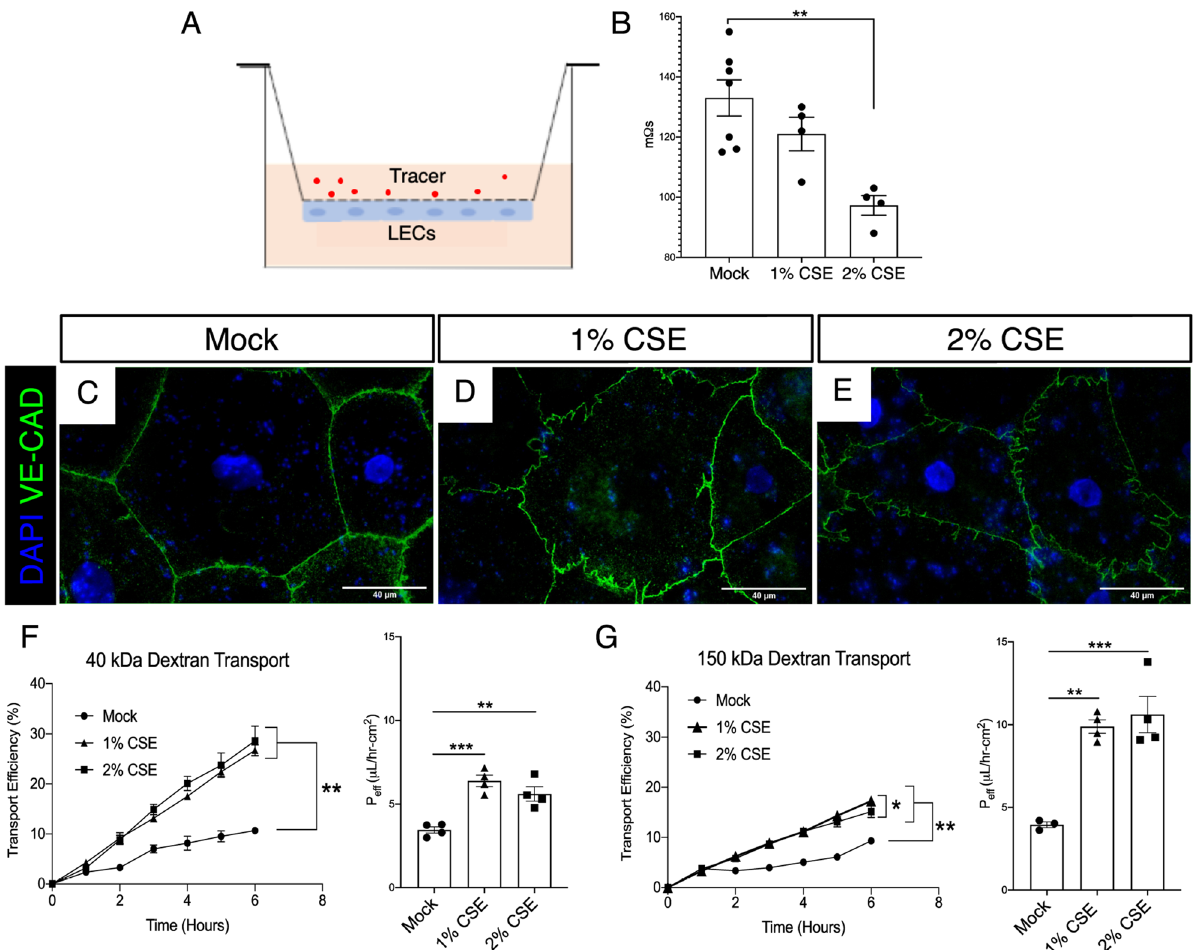
Figure 7. Cigarette smoke extract increases LEC permeability in vitro. ( A ) Schematic of LEC transport model where LECs are seeded on the bottom of a flask and transport of a fluorescent tracer across the monolayer is assessed. ( B ) Transendothelial electrical resistance (TEER) of a monolayer of LECs after treatment with 1% or 2% CSE for 12 h. ( C – E ) Representative fluorescent images of LECs stained for VE-cadherin (VE-CAD, green) after treatment with CSE for 24 h. ( F ) Transport efficiency of 40 kDa dextran across LEC monolayer shown over time (left) and as effective permeability (right, P eff µl/h-cm 2 ) at 6 h (n = 3–4). ( G ) Transport efficiency of 150 kDa dextran across LEC monolayer over time (left) and effective permeability (right, P eff µl/h-cm 2 ) at 6 h (n = 3–4). * P < 0.05, ** P < 0.01, *** P < 0.001. Scale bars = 40 µm. Microscopy images are representative of at least 4 replicates per